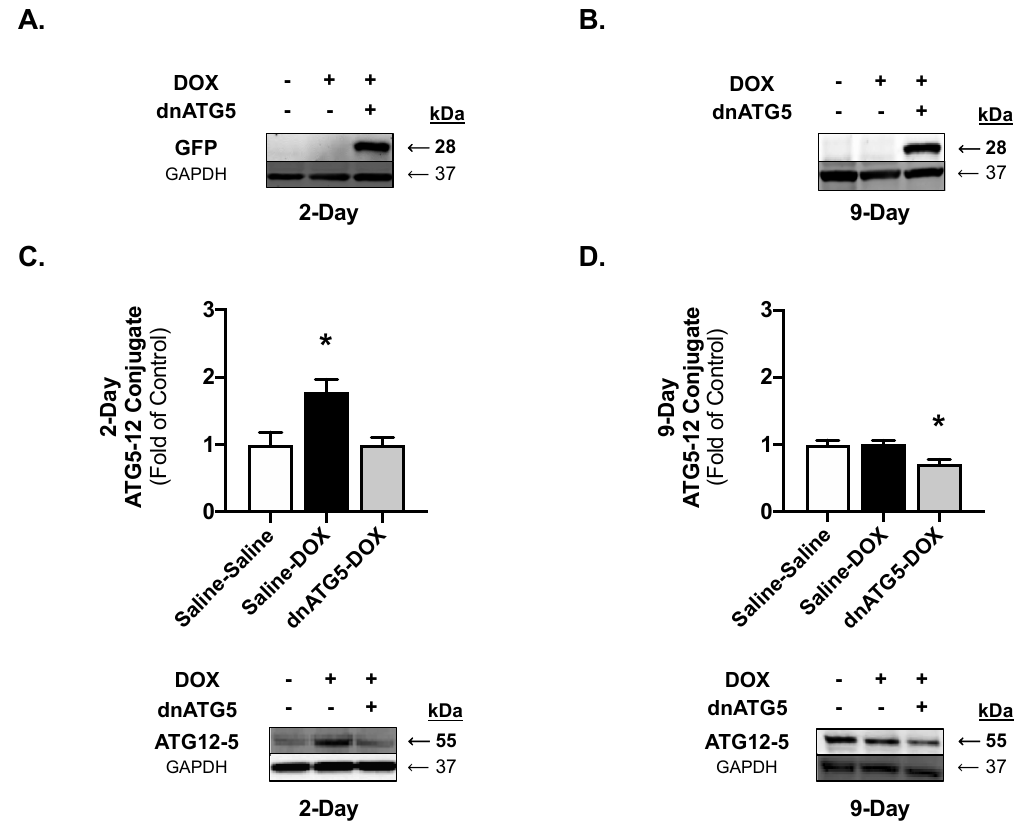
Figure 1. Treatment validation. Western blot to confirm the presence of the rAAV-dnATG5 green fluorescent protein (GFP) tag for the ( A ) 2-day and ( B ) 9-day timepoints. Western blot for the ATG5-ATG12 conjugation product for the ( C ) 2-day and ( D ) 9-day timepoints. Values are presented as means ± SEM, n = 7–8/group. Representative Western blot images are displayed below the graphs. * significantly different versus all groups ( p < 0.05).